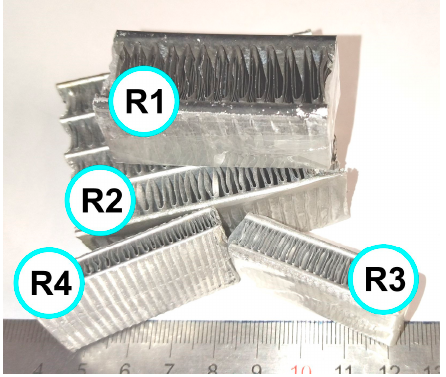
Figure 2. Examples of cores used for manufacturing the radiators.